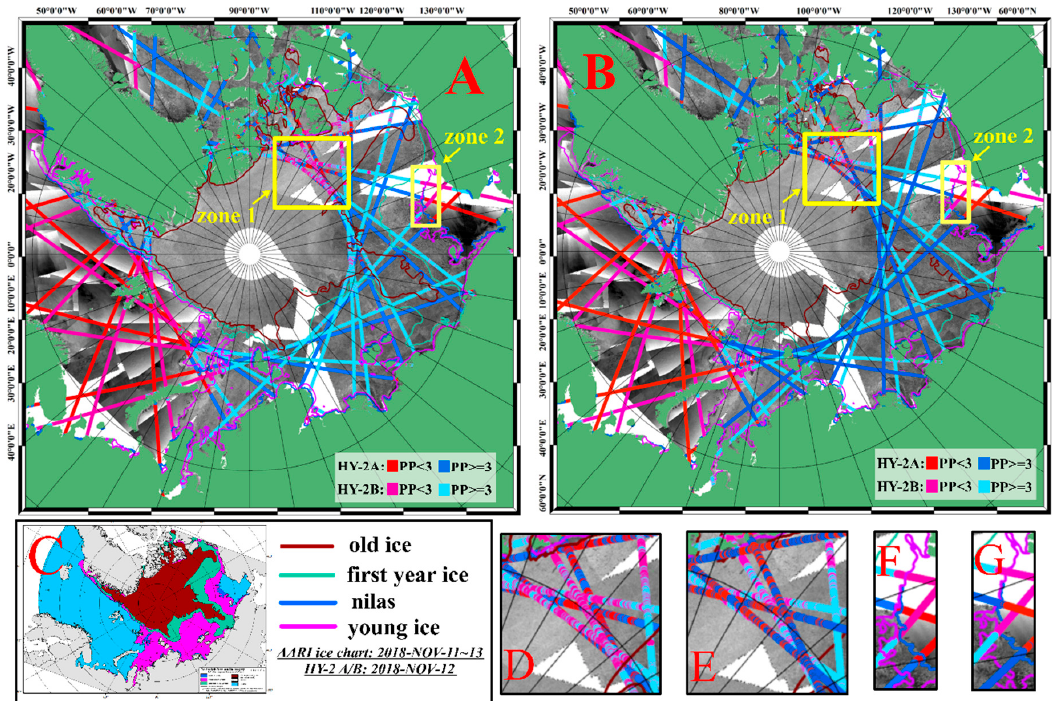
Figure 12. Distributions of the classifications of the HY-2A / B: A . Distributions of the classifications of the Ku Band’s PP values of HY-2B ALT data; B . distributions of the classifications of the C Band’s PP values of the HY-2B ALT data; C . AARI ice chart; D and E . enlarged drawings of zone 1 (old ice); F and G . enlarged drawings of zone 2 (nilas). Note: in Figure 12A,B, the same colors used in Figure 12C were used to indicate the edges of di ff erent ice